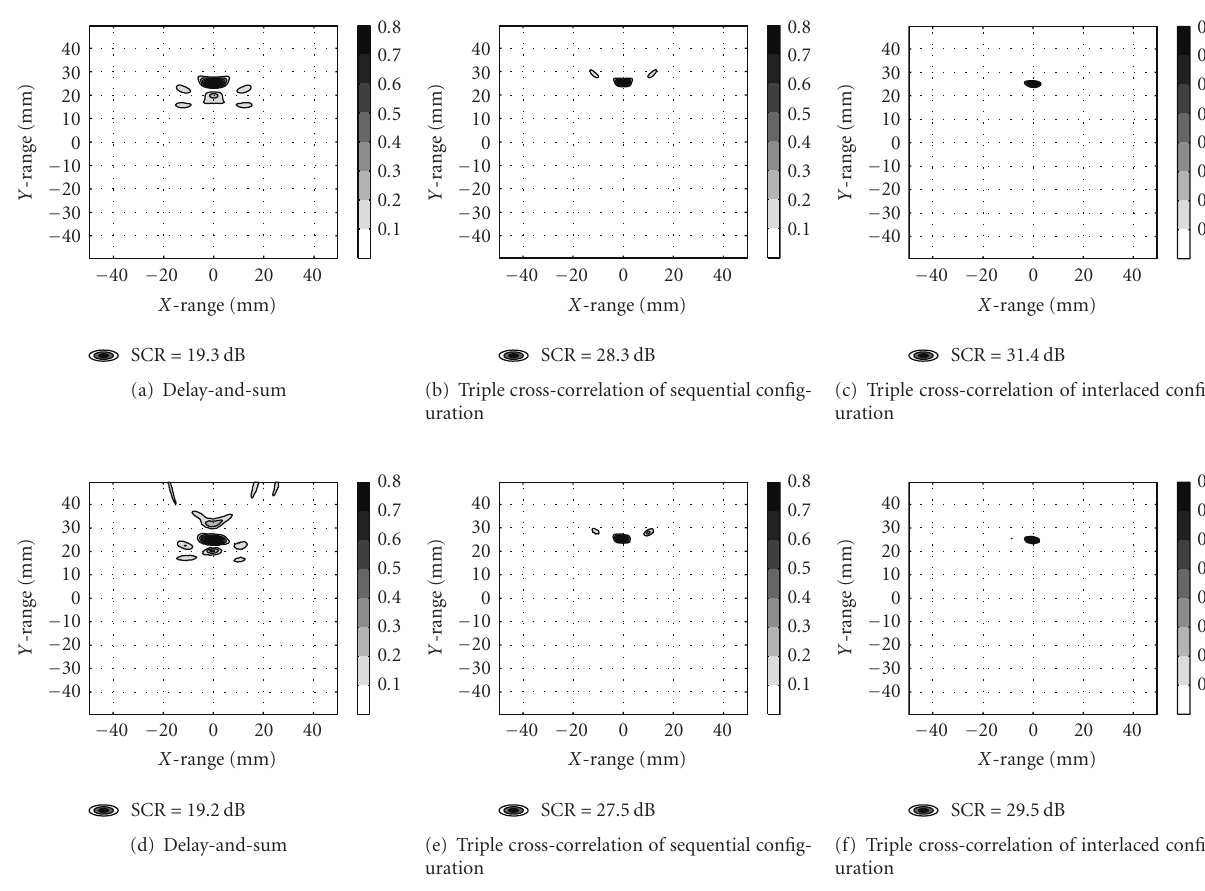
Figure 7: Grey-scale images of power deposition in numerical (upper panels) and experimental (lower panels) runs using 16 antennas.